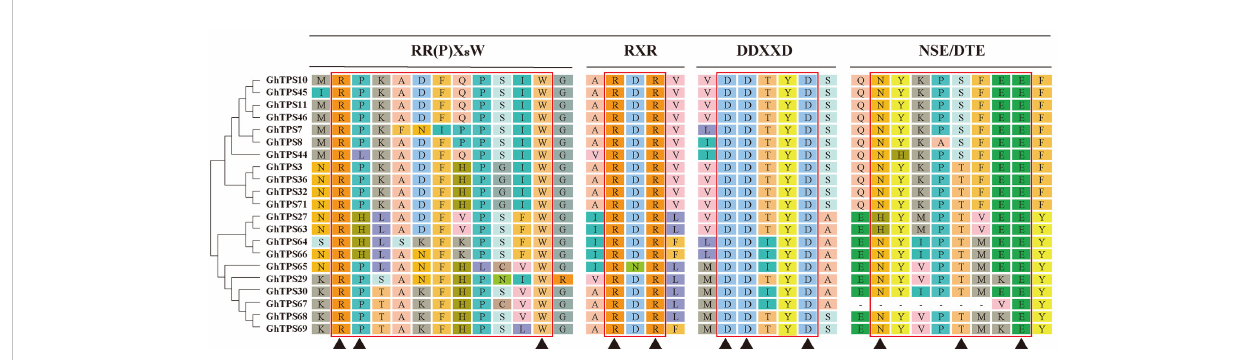
FIGURE 4 Schematic diagram of GhTPS-a conservative motif in G. hirsutum. On the left was GhTPS-a phylogenetic tree analysis of G. hirsutum . The red line was the conserved motif, the name of the conserved motif was indicated above, and ▲ was the conserved amino acid